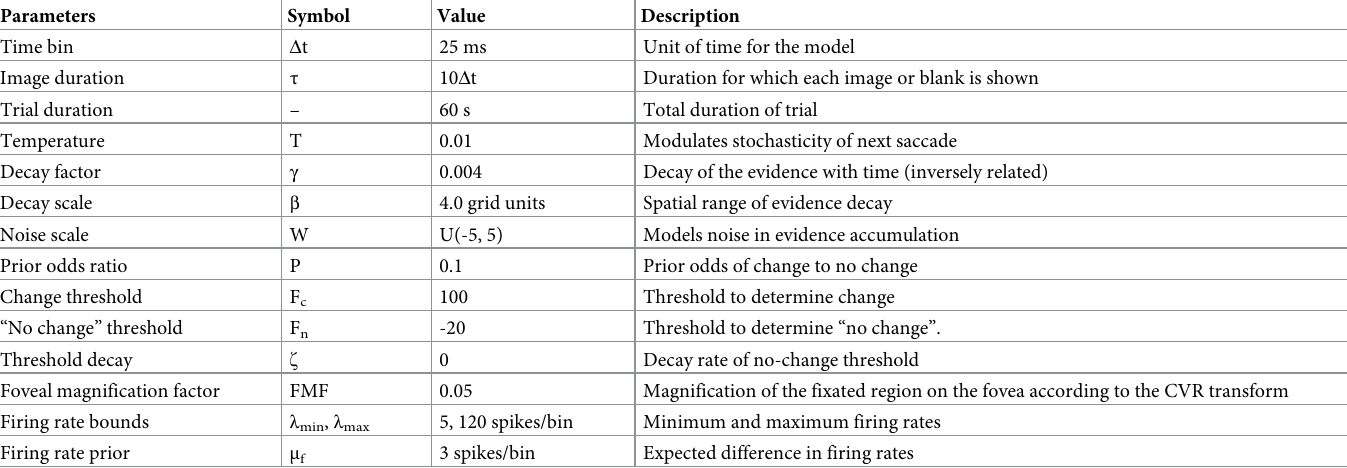
Table 1. Model parameters and their default